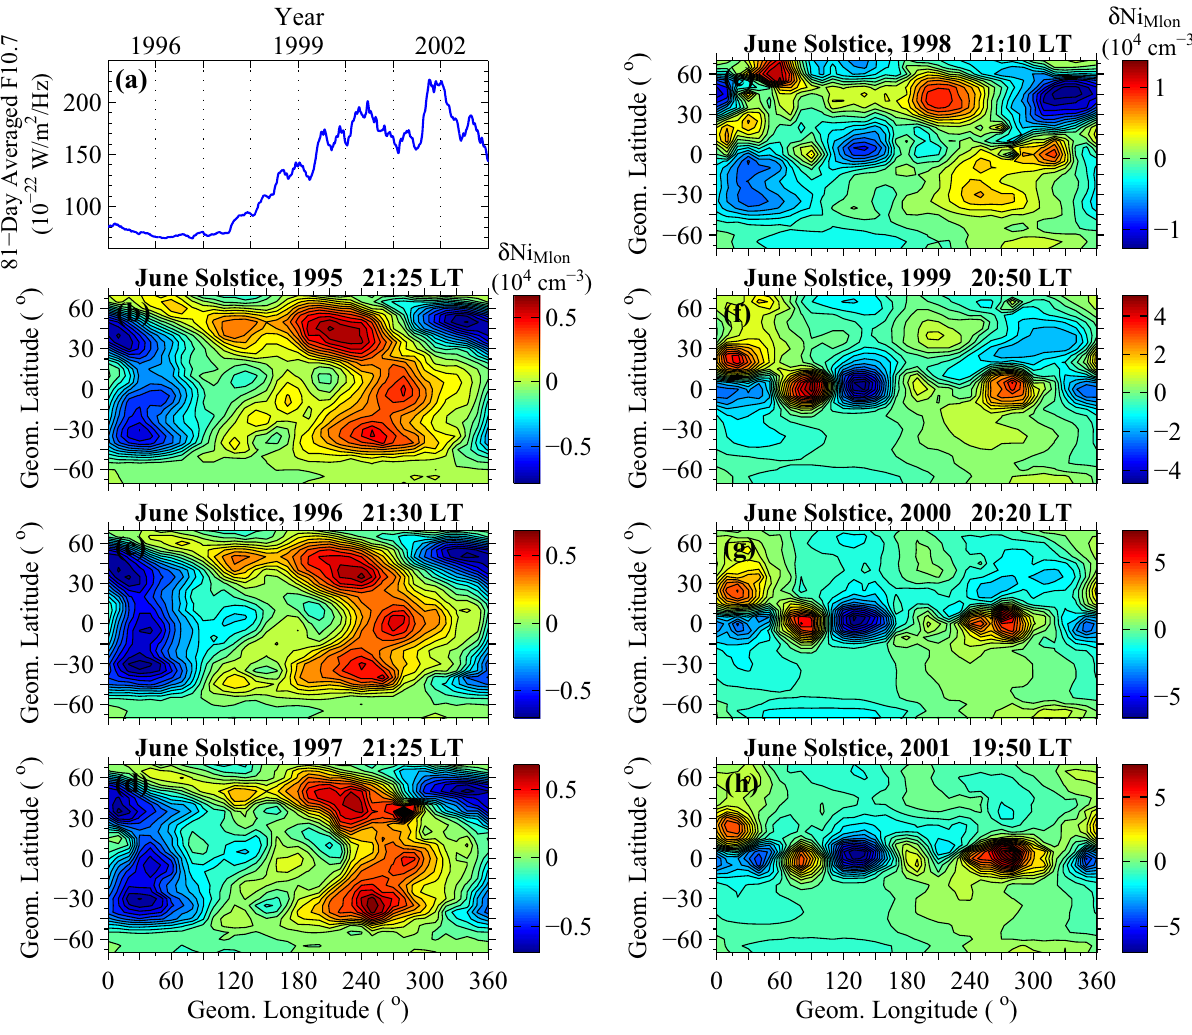
Fig. 5. (a) Variations of 81-day running averaged F 10.7 index from 1995 to 2002. (b – h) Same as Figure 1c but for DMSP F12 nightside measurements around the June Solstice of 1995 – 2001, respectively. The local time when the DMSP F12 satellite was over the equator is labeled at the top of each panel for reference; it shifted year by